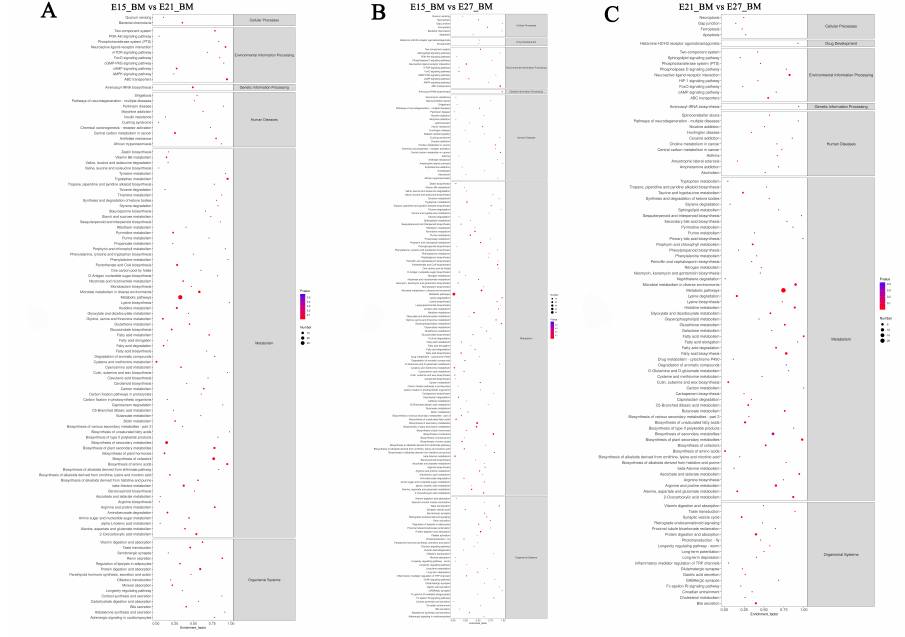
Figure 6. KEGG pathways of differentially accumulated metabolites (DAMs) enrichment in breast muscle. ( A ) E15_BM vs. E21_BM; ( B ) E15_BM vs. E27_BM; ( C ) E21_BM vs.